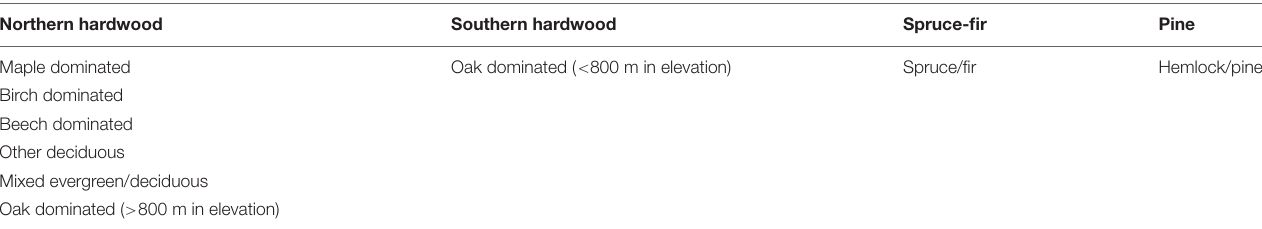
TABLE 2 | Forest types delineated by Lovett et al. (2002) and Driese et al. (2004) were grouped into one of four broader categories (northern hardwood, southern hardwood, spruce-fir, or pine) for the assessment of forest type distribution within the study